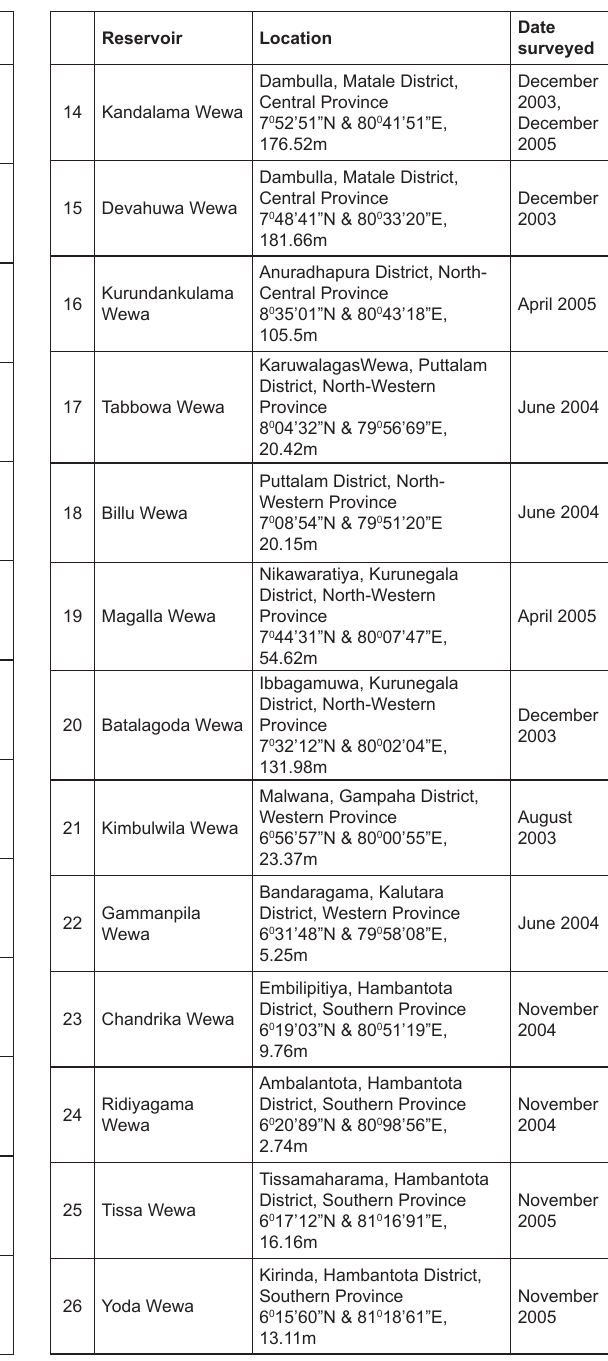
Table 1. The reservoirs of Sri Lanka surveyed for tiger beetles